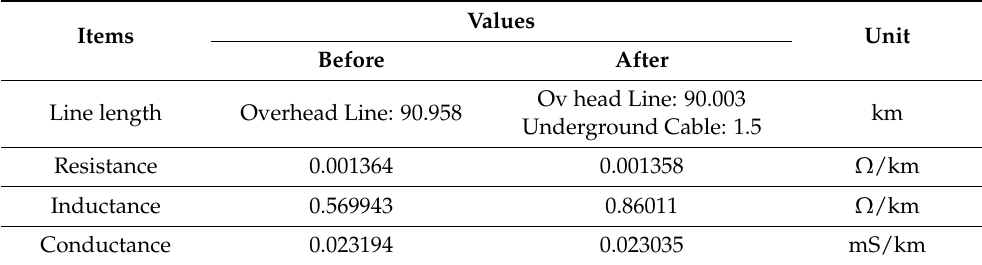
Table 1. Line Impedance before and after